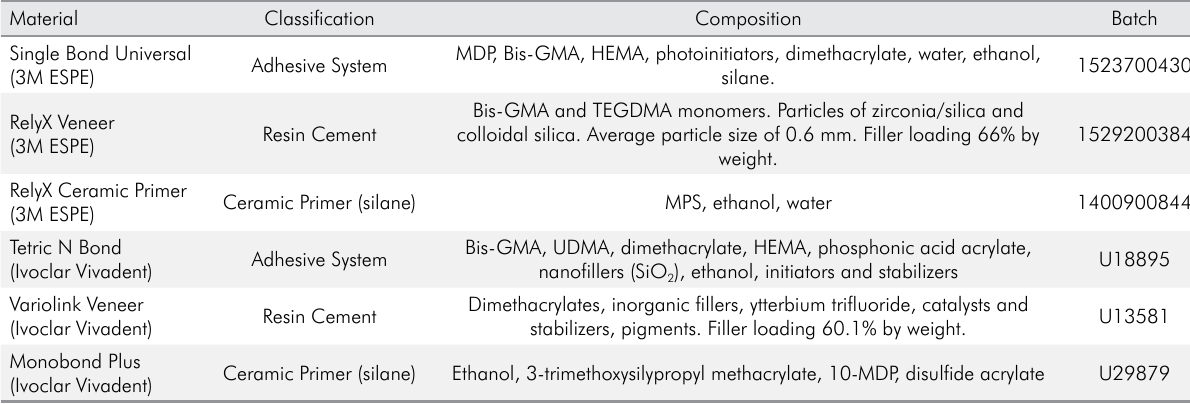
Table 1. Materials, classification, composition, and batch number of materials tested.